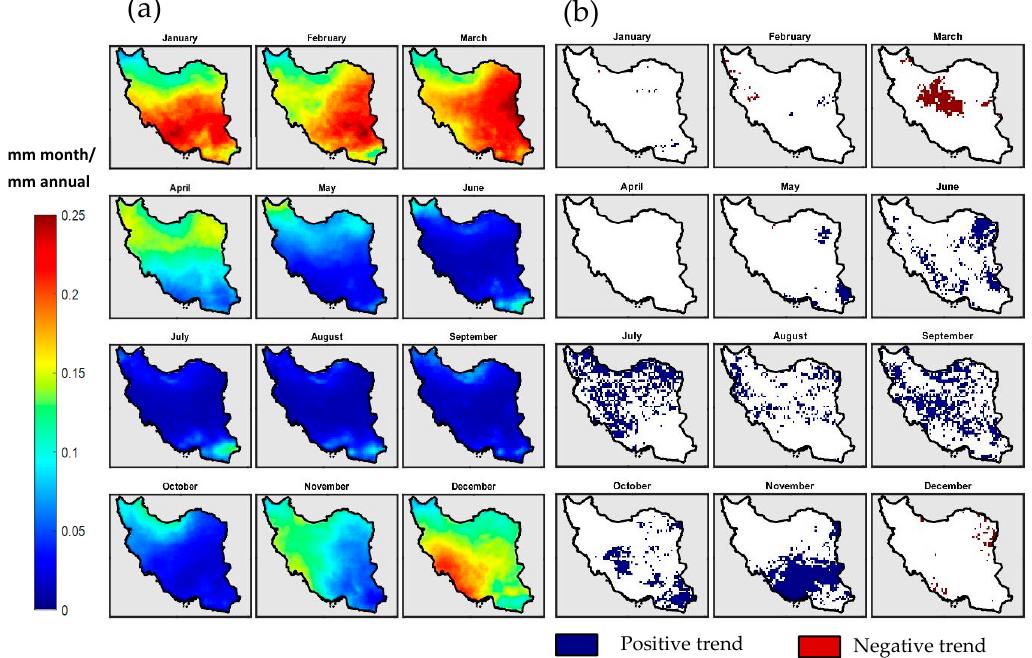
Figure 7. ( a ) Average percentage of each month contribution in annual precipitation; ( b ) monthly contribution trend analysis, blue and red part present the positive and negative trend, respectively.